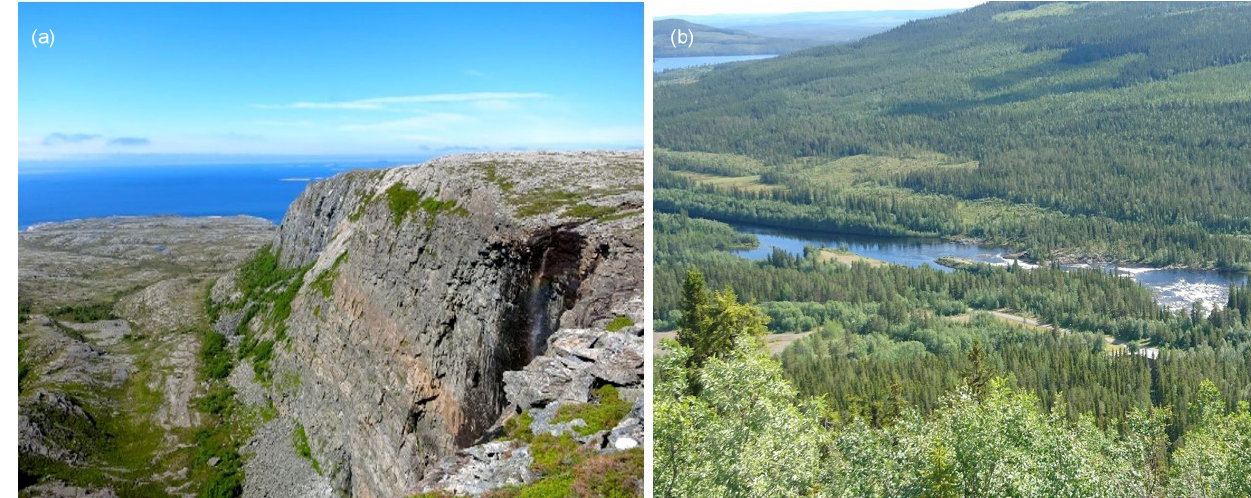
Figure 4. The variations in terrain and roughness covered in the validation dataset. Panel (a) depicts a site in complex terrain on the Norwegian west coast and (b) a forested inland site in Sweden.